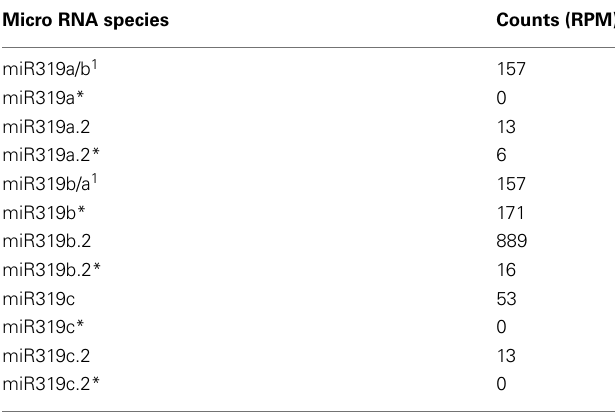
Table 1 | Number of representative reads for specific miR319 species and additional miRNAs generated from their